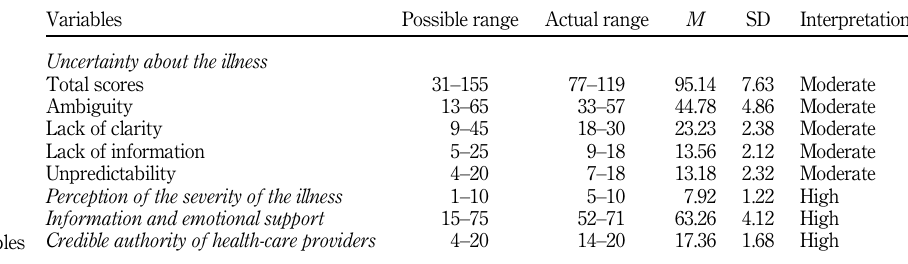
Table 3. The score of